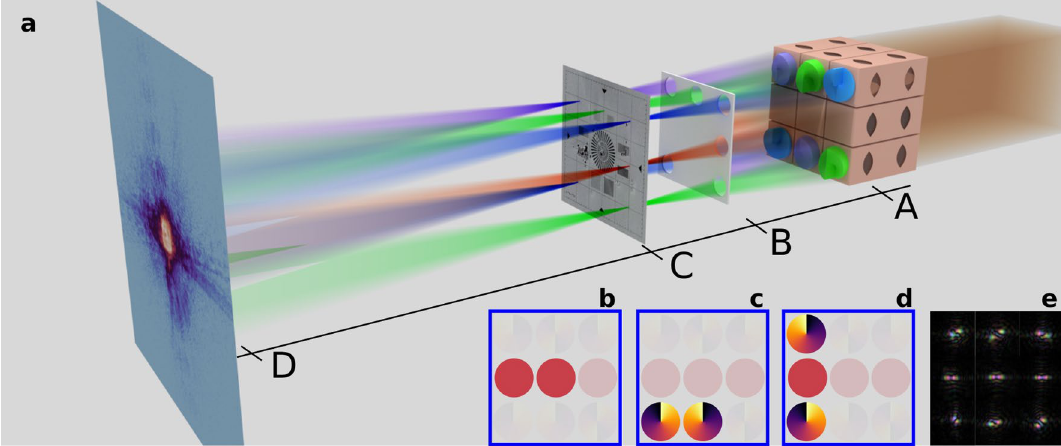
Figure 1. ( a ) Experimental setup with the lens array (A), the pinhole array (B), the sample (C) and the detector (D). ( b ) Lens combination generating two uncoded probes. ( c ) Lens combination generating two coded probes. ( d ) Lens combination generating three coded probes. ( e ) All nine probes, reconstructed in the sample plane at 7